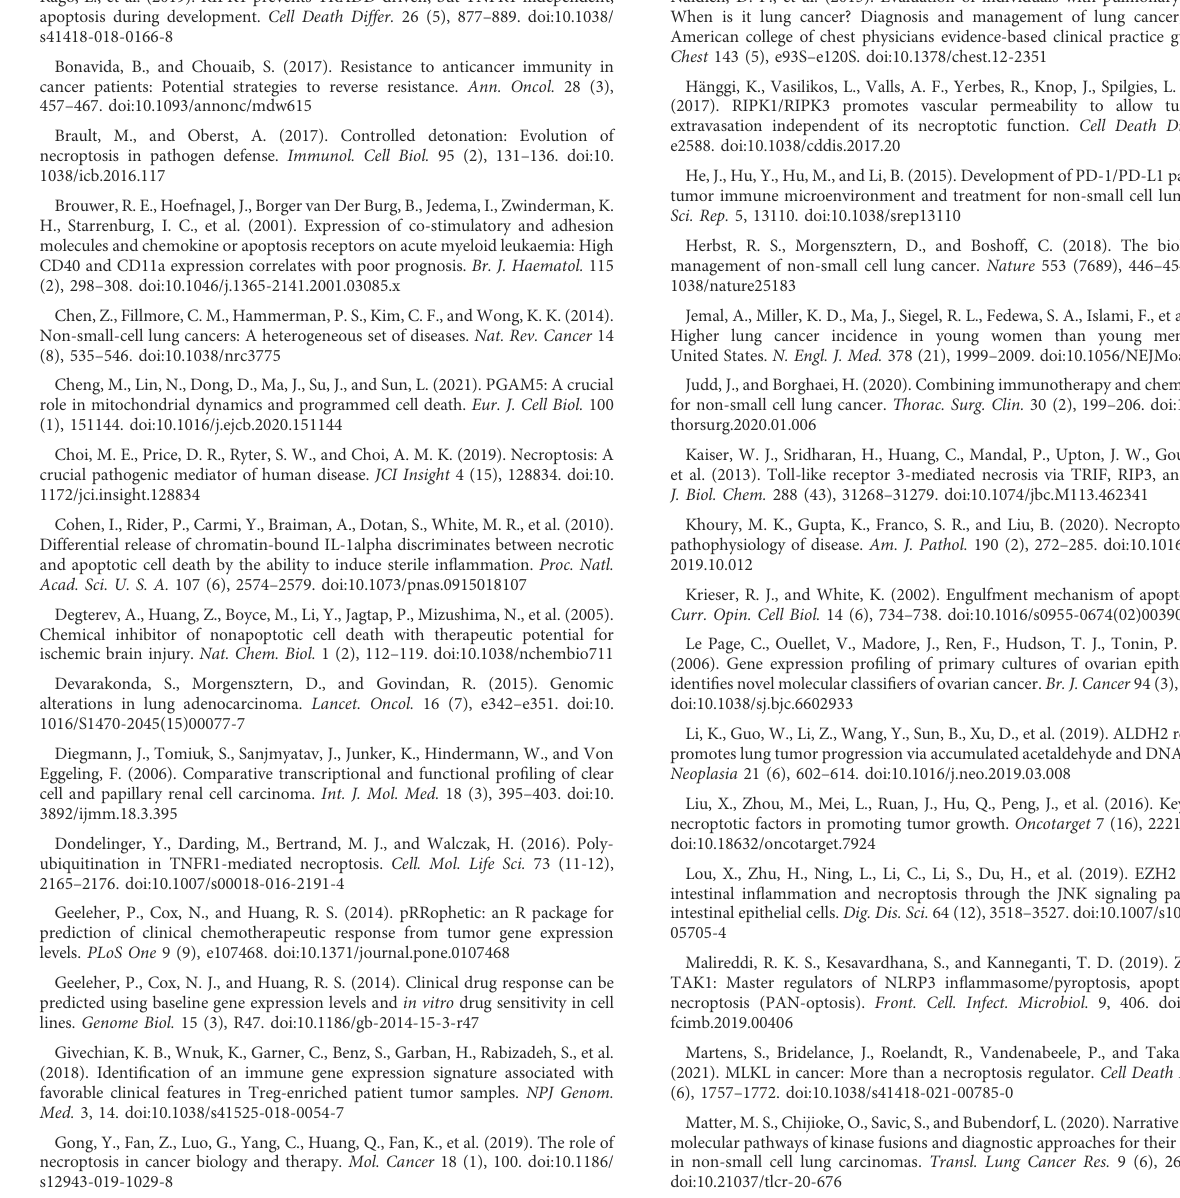
SUPPLEMENTARY FIGURE S1 Immunohistochemical (IHC) staining results of expression levels of the 13 necroptotic proteins (RIPK1, TLR3, TLR4, TNFRSF1A, PGAM5, ZBP1, NR2C2, HMGB1, USP22, TRAF2, ALDH2, EZH2, NDRG2) between LUAD and normal lung